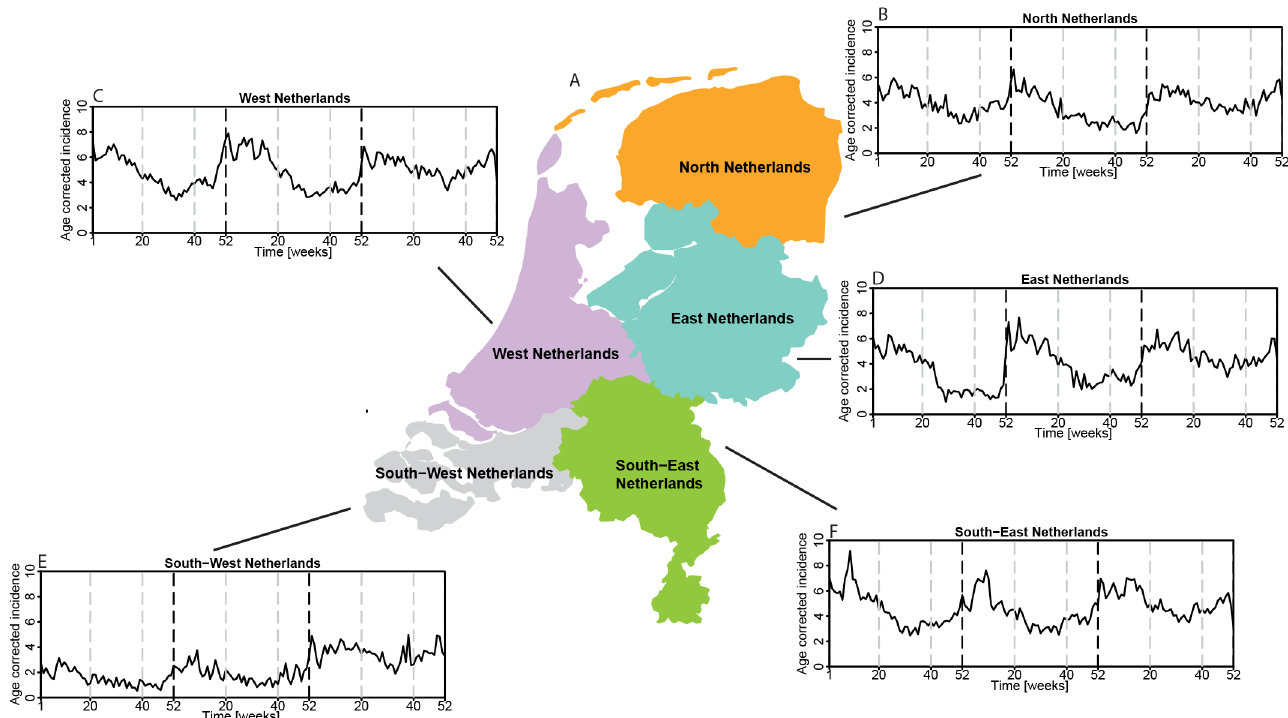
Fig 5. Map of the Netherlands divided in five regions. Time series of age-adjusted incidence[x 100,000per week] of unspecified pneumonia for the five regionsof the Netherlands (b-f).